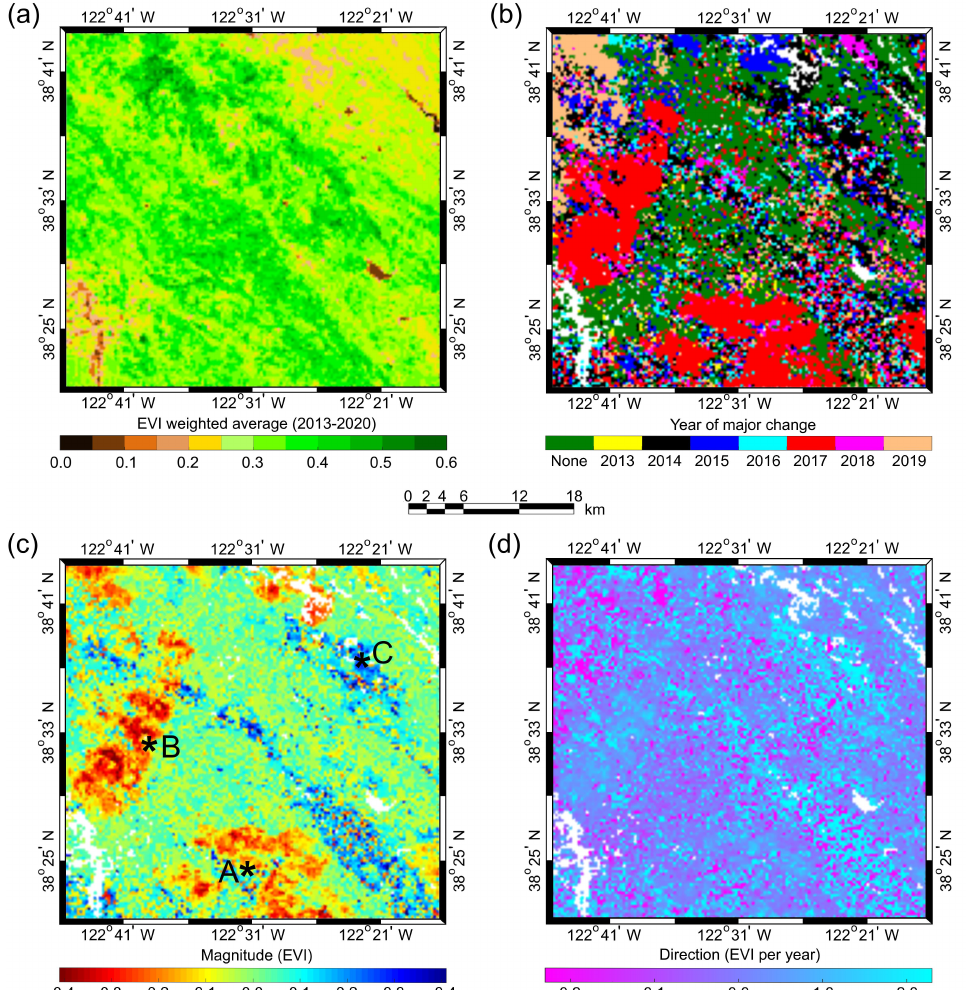
Figure 13. The results of analyzing the Landsat 8 weighted EVI time series since 2013. ( a ) The weighted average of all EVI images as a proxy for vegetation coverage within the second study region during 2013–2020, ( b ) the year of jump with the largest absolute value of magnitude ( | MAG | < 0.05 is shown in green), ( c ) the magnitude of jump, and ( d ) the direction of jump. Panels ( b – d ) are only for the areas where the weighted average of EVIs is greater than 0.2. The more detailed analyses of EVI time series corresponding to pixels A, B, and C in panel ( c ) are demonstrated in Figures 14–16,